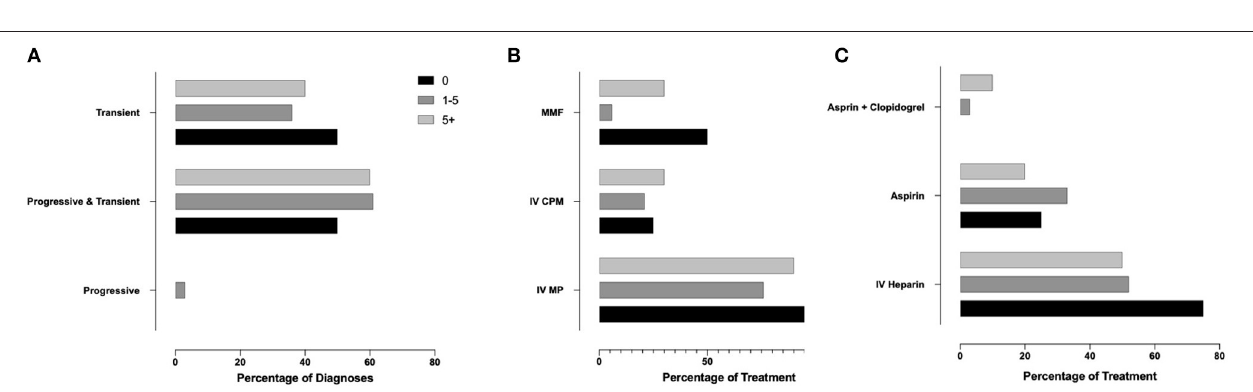
FIGURE 7 | Influence of Experience in Approach to Diagnosis and Treatment in case 2. (A) Correlation between number of years of experience clinicians had and their diagnosis of the patient in case 2. (B) Years of experiences vs. Induction treatment. (C) Years of experience vs. Acute anticoagulation treatment.